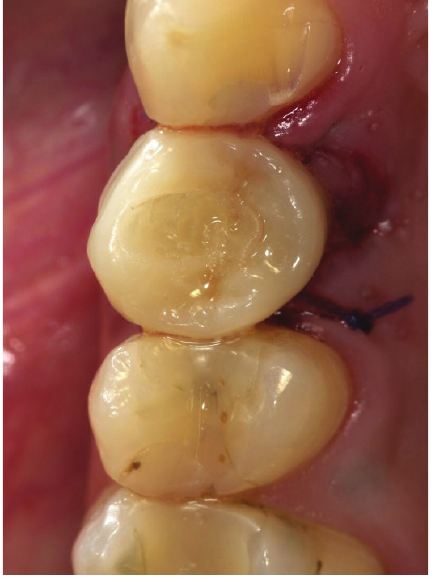
Figure 13: The provisional rehabilitation was immediately fixed removing maximum intercuspidation contacts to ensure the